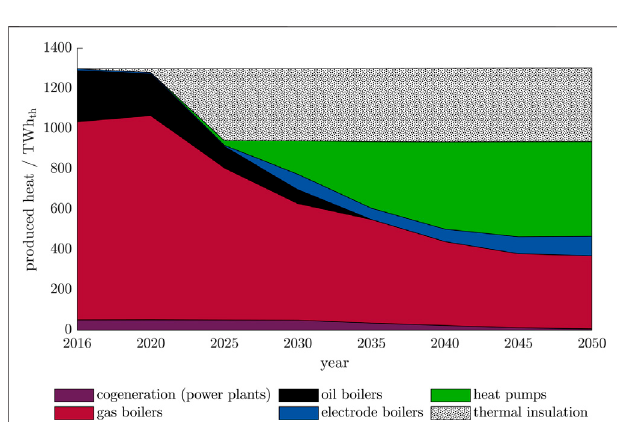
FIGURE 3 | Provided heating demand in Germany during the energy transition from 2016 to 2050. Thermal insulation reduces overall domestic heating demand. Temperature levels of the heating demand as well as centralized and decentralized heating demands are lumped for clarity of presentation. Gas boilers can be fueled by (synthetic) natural